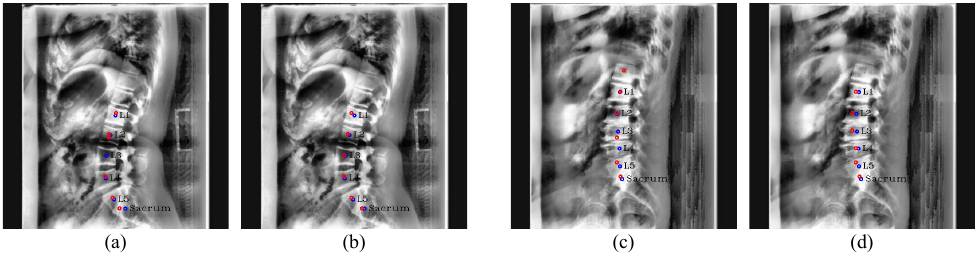
Figure 10. Inference results between kernel size of Pose-Net. ( b , d ) are Pose-Net results with the kernel size of 13 × 13, while ( a , c ) are Pose-Net results with the kernel size of 7 × 7. The red circles denote the predicated centers of L1, L2, L3, L4, L5, and the sacrum in order from the top, and blue circles and labels denote the ground truth of the